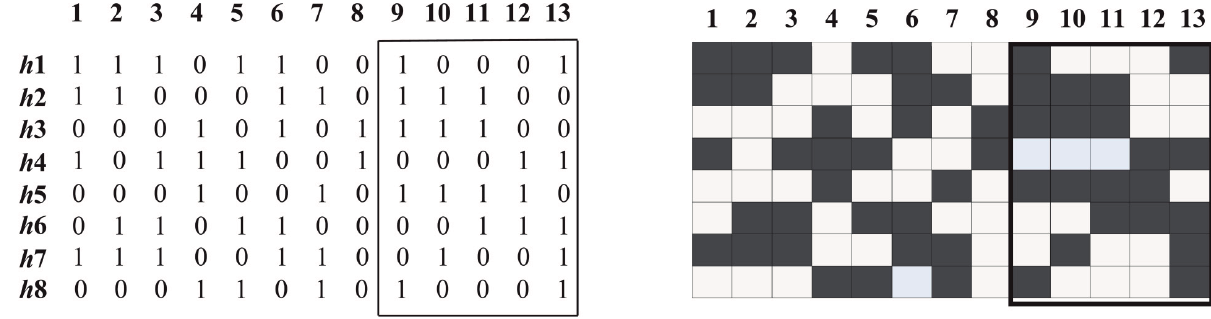
Figure 7. A haplotype matrix B and its corresponding submatrix M (8,